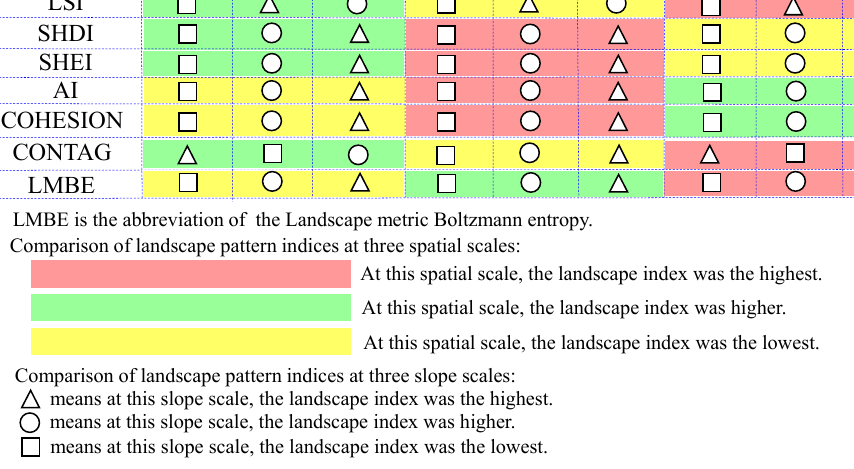
Figure 4. Comparison of landscape index under different scales.